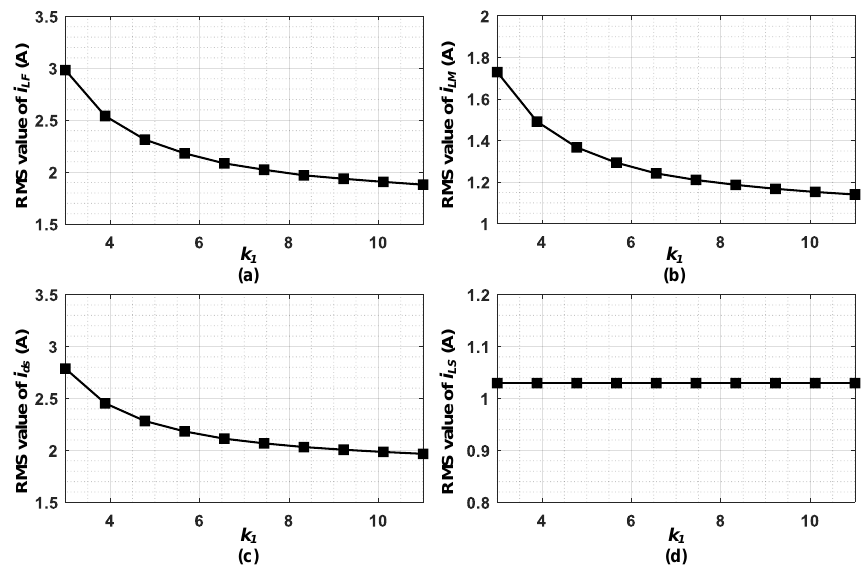
Figure 6. RMS values of branch currents under different k 1 values when selecting k 2 = 1.1. ( a ) RMS values of i LF ( t ); ( b ) RMS values of i LM ( t ); ( c ) RMS values of i ds ( t ); ( d ) RMS values of i LS ( t ). Furthermore, at k 1 = 10 and a scanning k 2 from 1.05 to 1.25, waveforms of i LF ( t ), i LM ( t ),